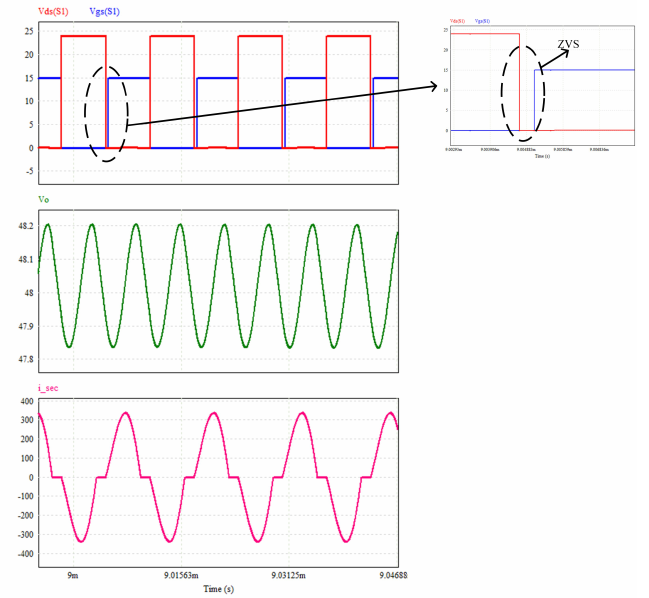
Figure 7. Simulation waveforms of the gate driver signal ( V gs ) and drain-source voltage ( V ds